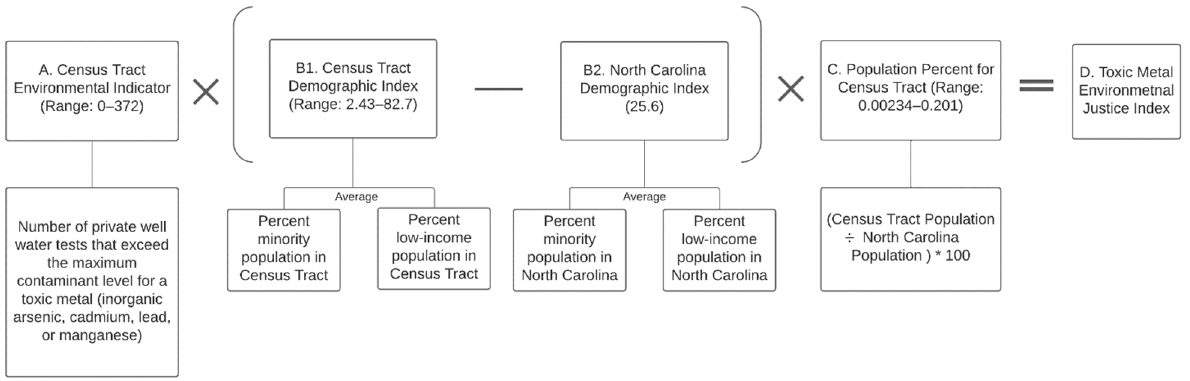
Figure 1. Mathematical formula for TM-EJIs, a product of an environmental indicator, a demographic index, and a census tract’s population (* indicates a multiplication factor).